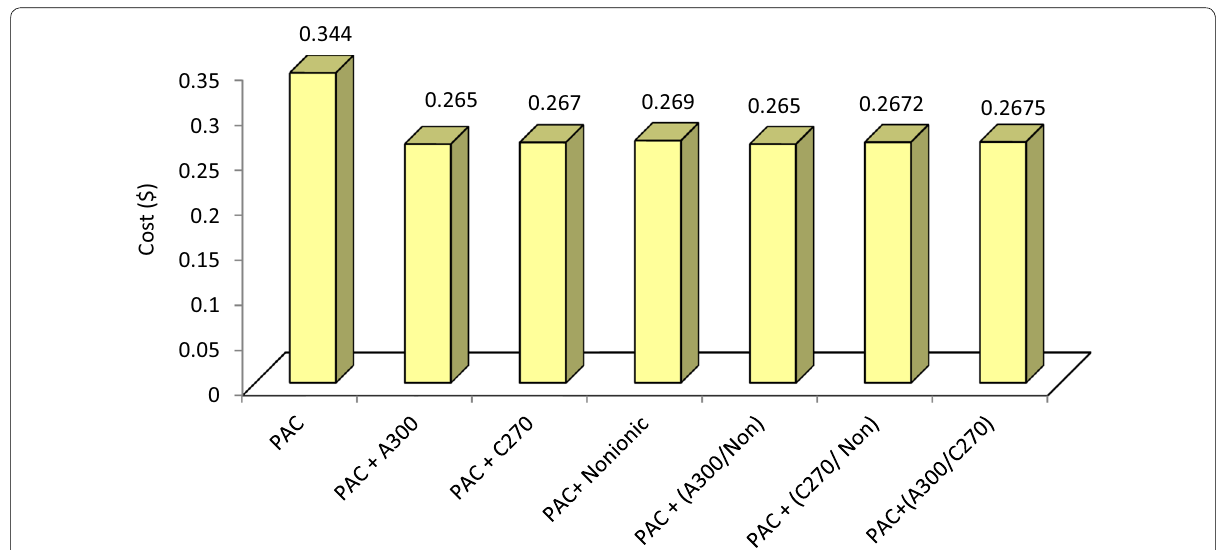
Fig. 7 Cost of different options of coagulant—polymers for treatment of one cubic meter of ceramic tile